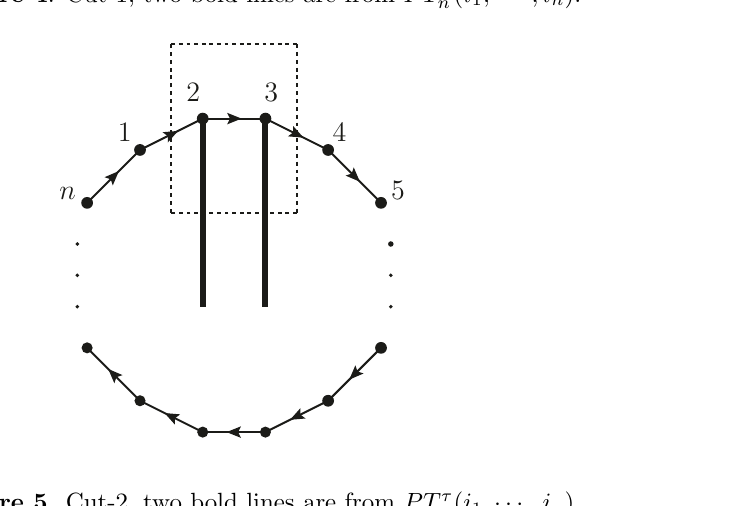
Figure 4 . Cut-1, two bold lines are from PT (cid:28)